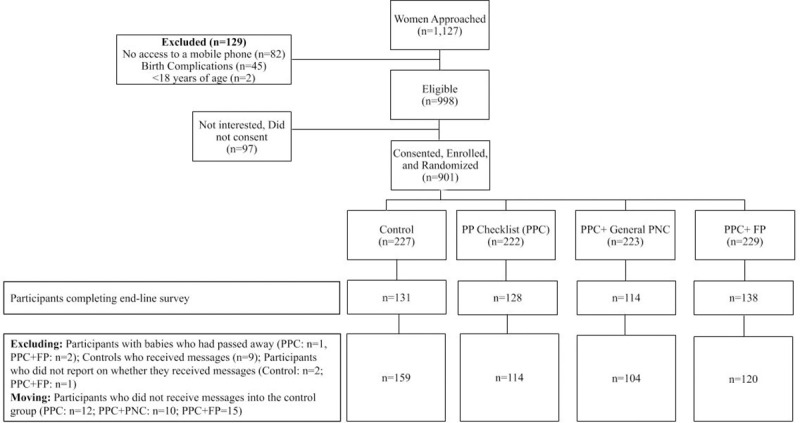
Flow chart of participant enrolment and study arm allocations.